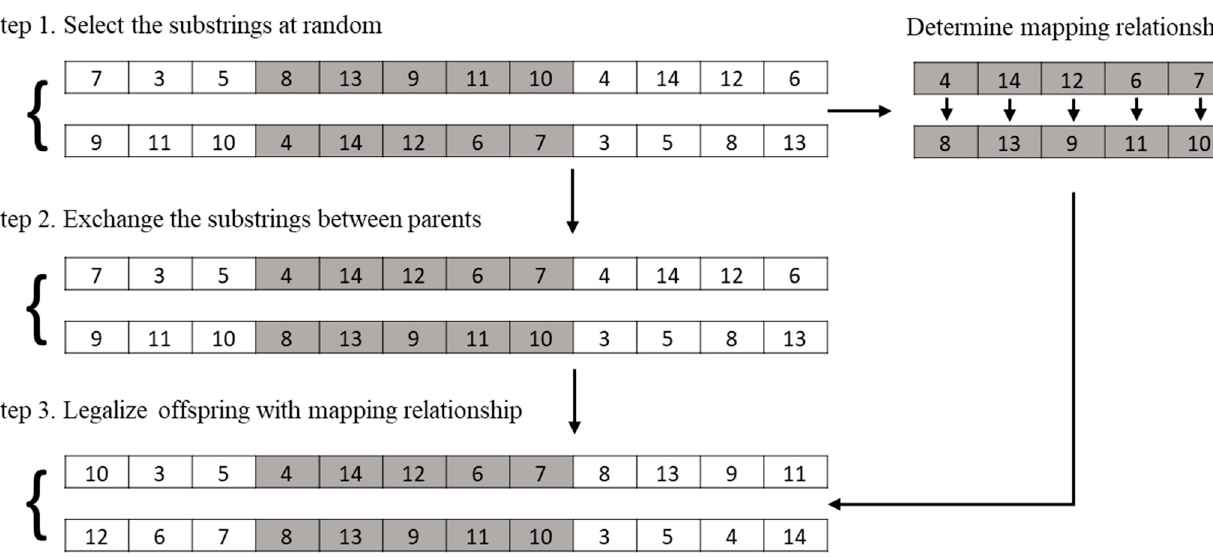
Figure 4. An illustration of partially mapped crossover (PMX), the proposed GA.